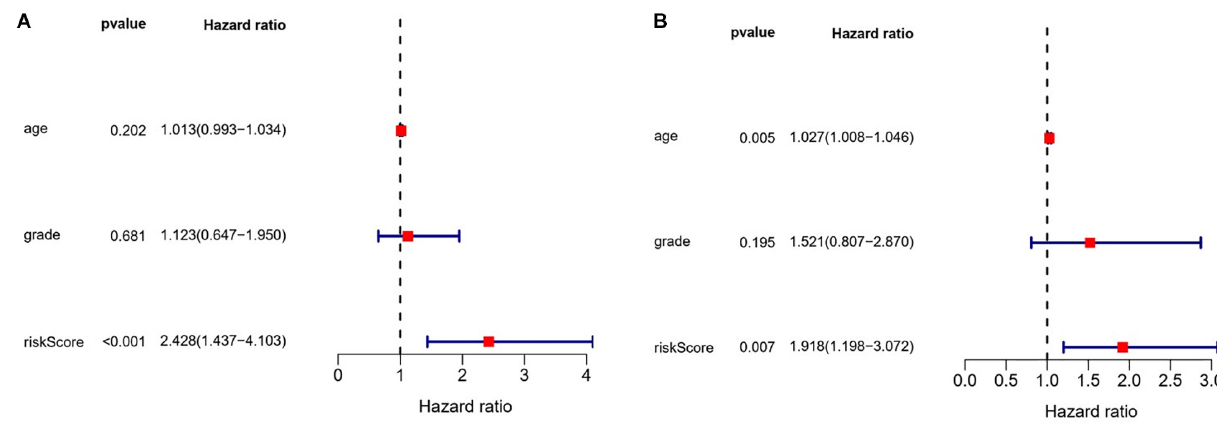
FIGURE 10 | Evaluation of the prognostic value of different clinical parameters by multivariate analysis. (A) Training cohort. (B) Test cohort.